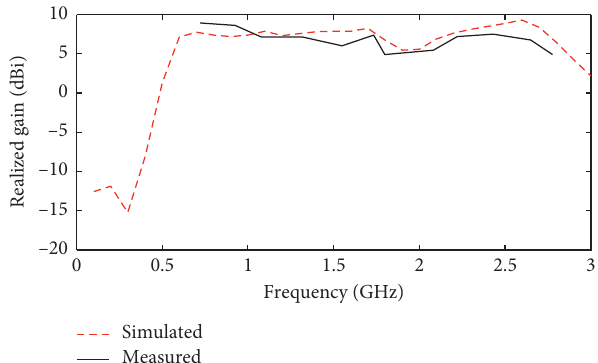
Figure 7: Simulated and measured peak gain of the proposed antenna